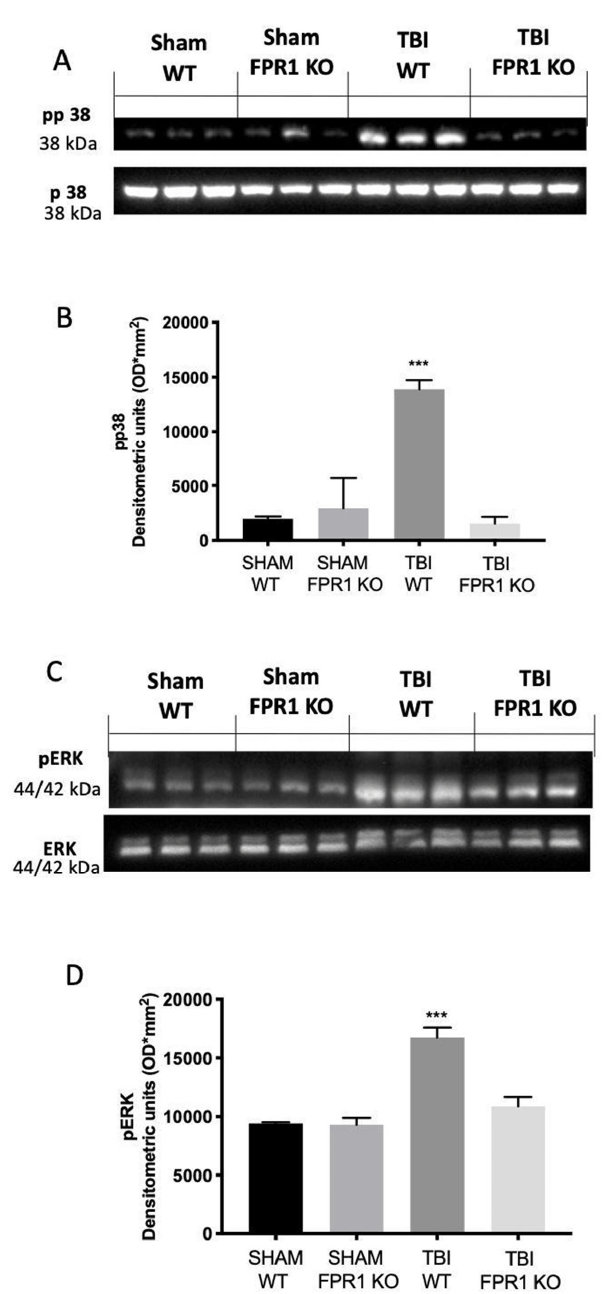
Figure 3. Effect of the absence of Fpr1 on p38 and ERK phosphorylation: Molecular analysis shows an increased p38 ( A ) and ERK ( C ) phosphorylation in the TBI WT group 24 h after injury, compared to the Sham WT group and Sham Fpr1 KO group. TBI Fpr1 KO animals do not show any significant phosphorylation, see densitometric analysis ( B , D ). For the analyses, n = 5 animals from each group were employed. Results were analyzed by two-way ANOVA followed by a Bonferroni post-hoc test for multiple comparisons. Non-parametric data were analyzed with Fisher’s exact test. *** p < 0.001 vs. Sham WT.